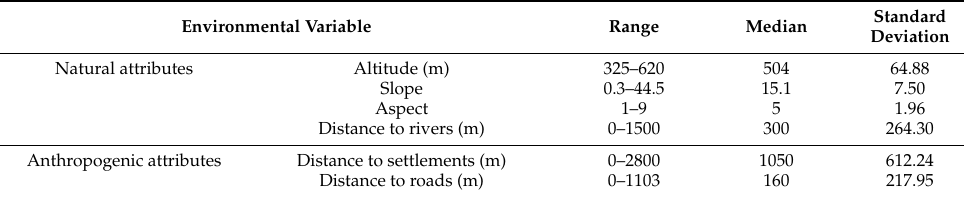
Table 5. Statistical analysis of environmental diversity in